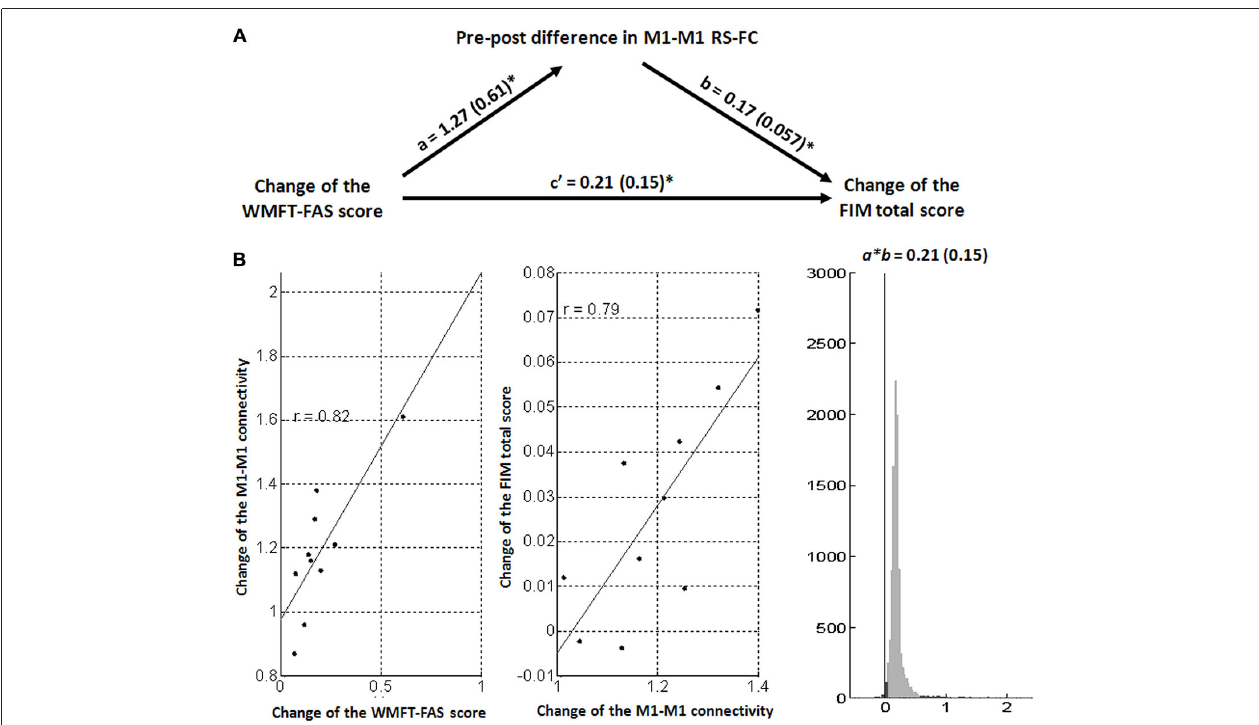
FIGURE 3 | Mediation analysis results. (A) Path diagram shows the relationships between change scores on the WMFT-FAS and FIM from pre-treatment and the pre-to-post difference in interhemispheric M1-M1 RS-FC. The predictor region in the WMFT-FAS score is shown at the left, which predicts the M1-M1 RS-FC. This is the a path. The lines are labeled with path coefficients, and standard errors are shown in parentheses. The mediator factor (M1-M1 RS-FC) connection to the outcome (FIM total score) is the b path. This is calculated controlling for the WMFT-FAS and for the mediator factor, as is standard in mediation models. ∗ p < 0.05, two-tailed. (B) Partial regression scatterplots for the (left panel) WMFT-FAS–M1-M1 RS-FC and for the (center panel) M1-M1 RS-FC–FIM total score relation. The right panel shows an example of a bootstrapped mediation effect (path a × b ) for the M1-M1